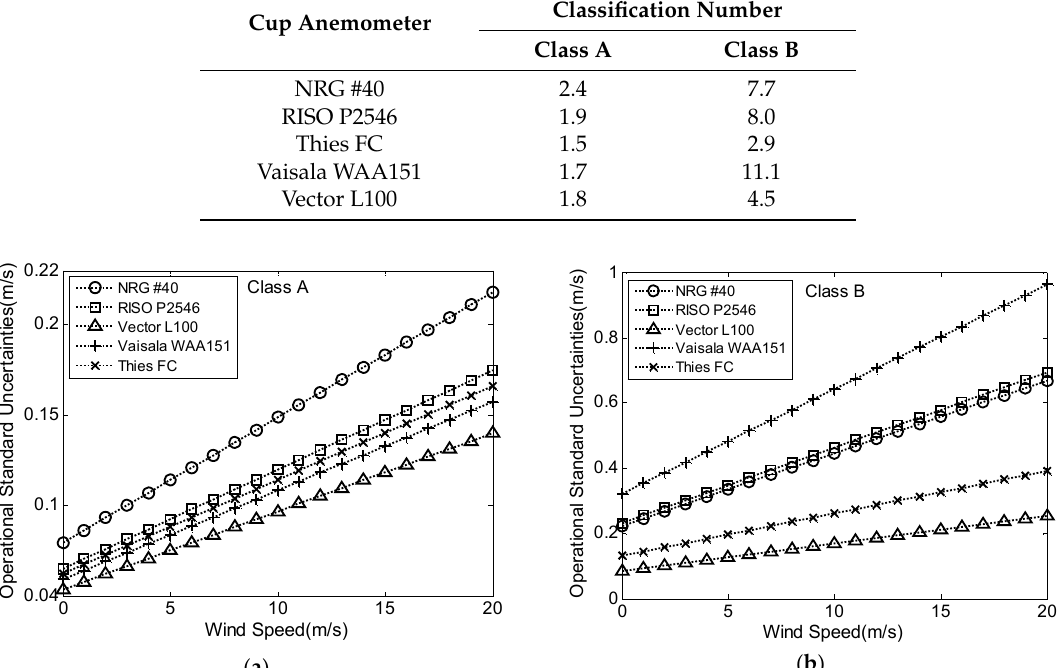
Figure 1. Operational standard uncertainty of five anemometers: ( a ) in class A operational ranges; ( b ) in class B operational ranges.